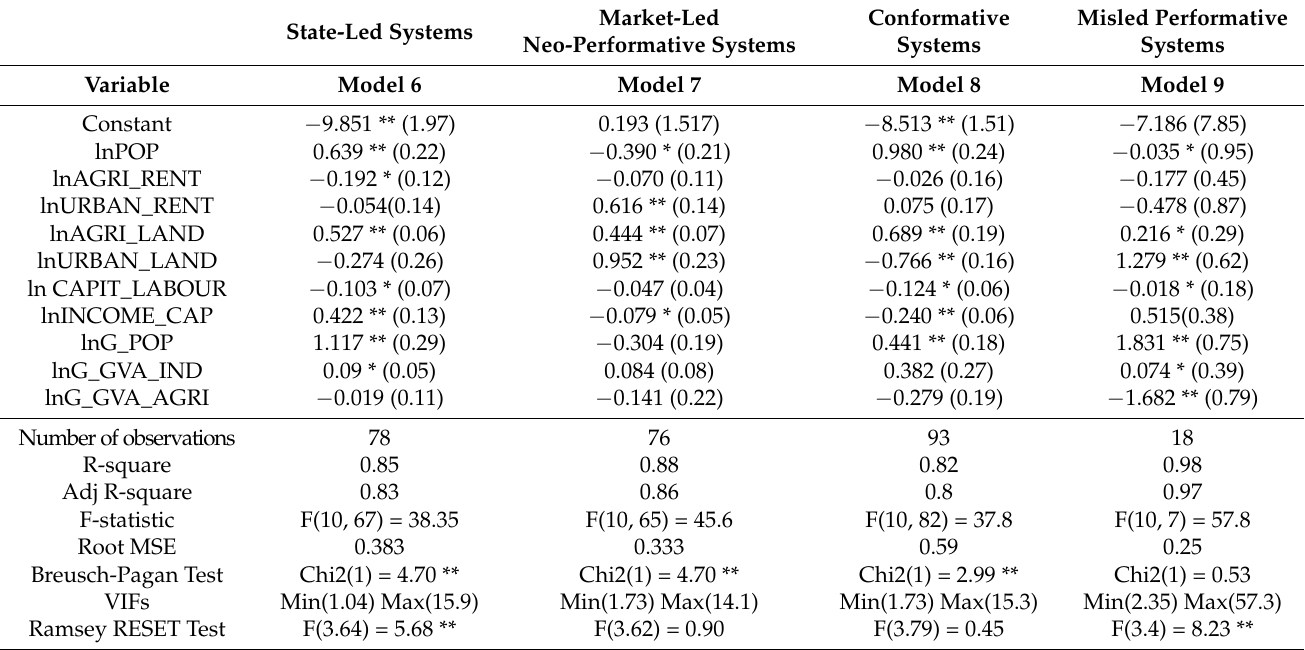
Table 3. The socio-economic drivers of agricultural land conversion to urban use across different planning systems (OLS model